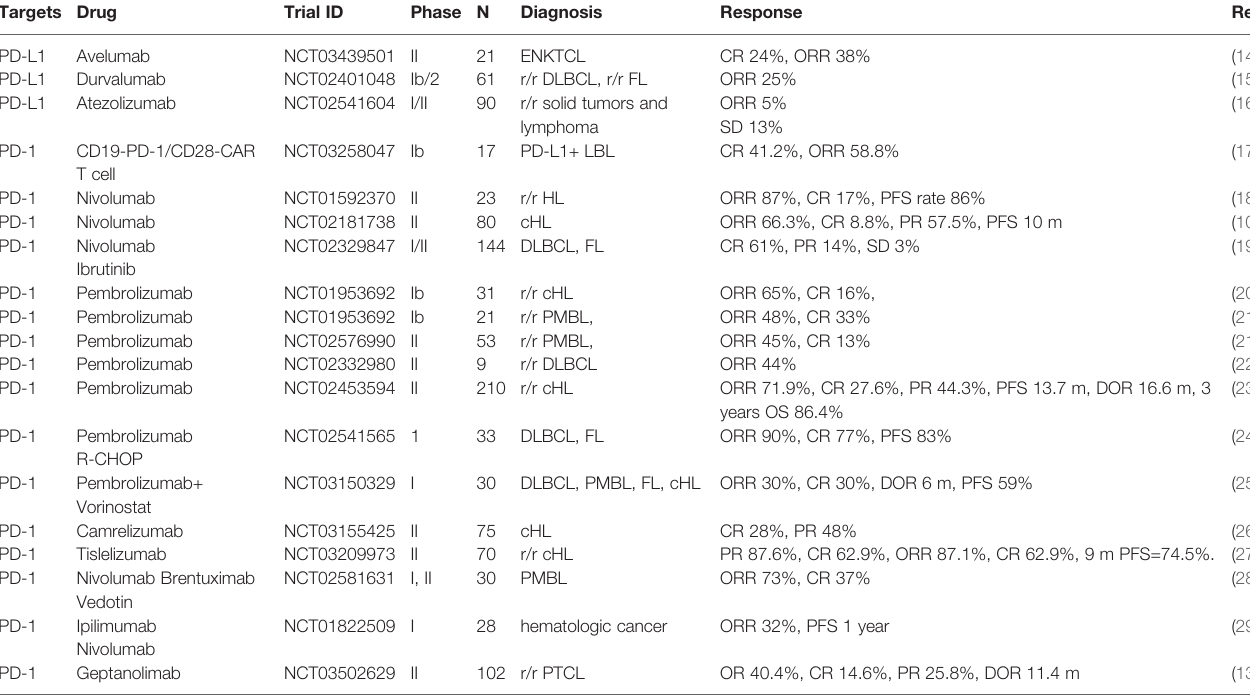
TABLE 1 | The fi nished clinical trials targeting on B7 family molecules in